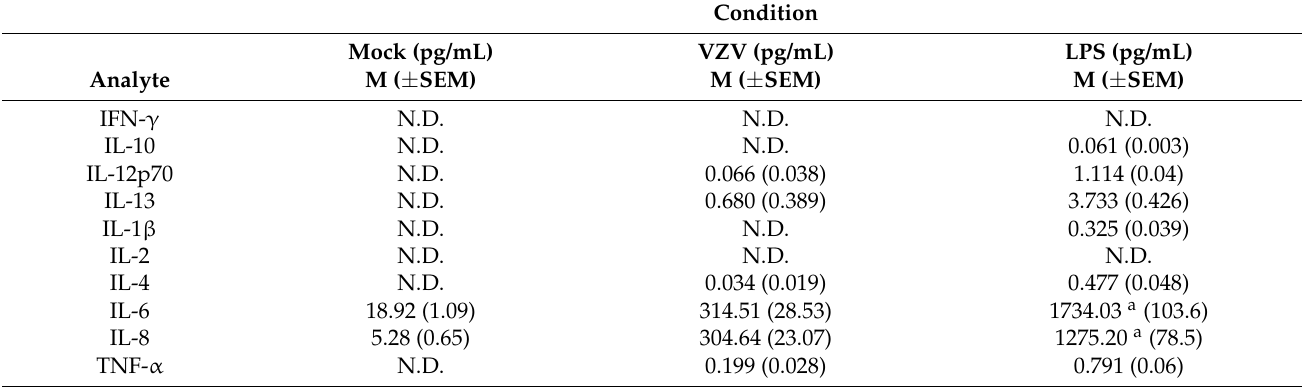
Table 1. Meso Scale Discovery proinflammatory cytokine analyte levels in conditioned supernatant from mock- and VZV-infected human adrenal cortical cells